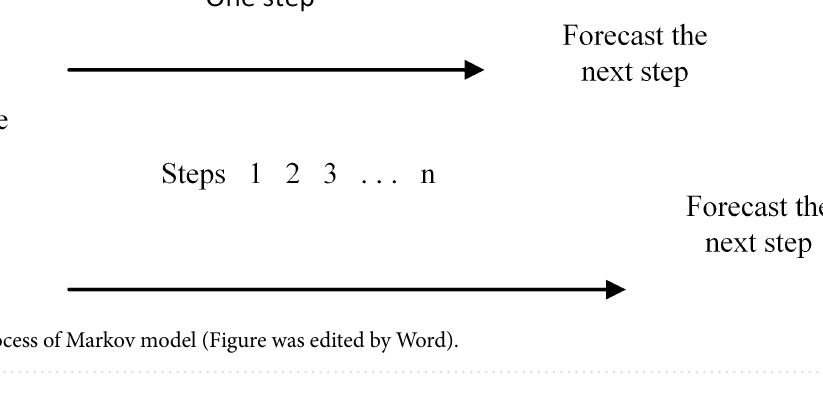
Figure 3. The process of Markov model (Figure was edited by